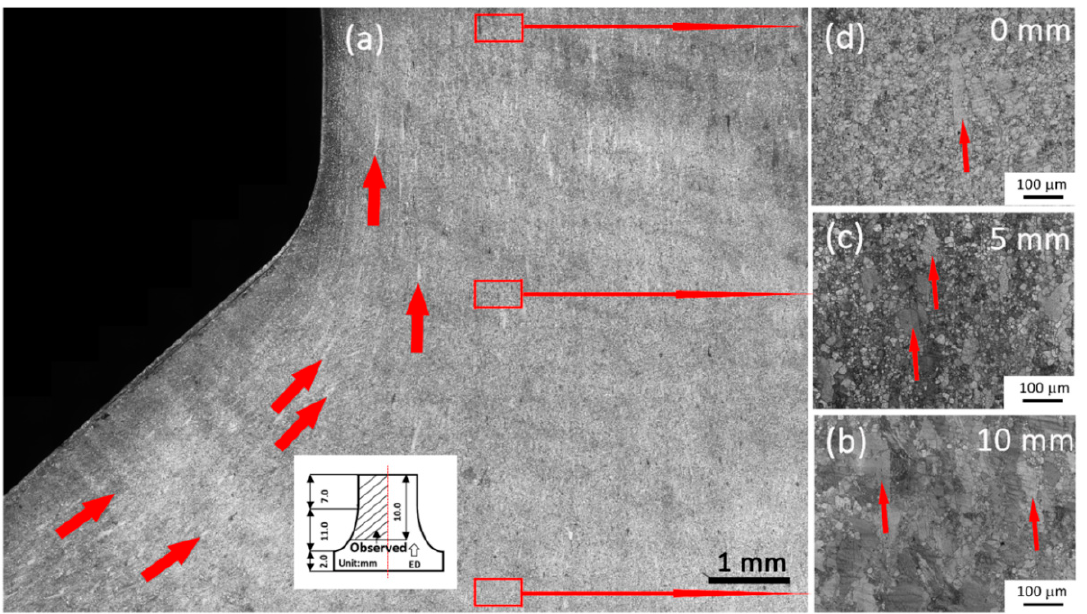
Figure 7. Optical micrographs of the interrupted die sample extruded at 400 °C at different positions shown in schematic illustration (see inset): ( a ) large overview of the area near the die exit, and ( b – d ) indicate different locations below the die exit. Red arrows indicate the large unDRXed grains.